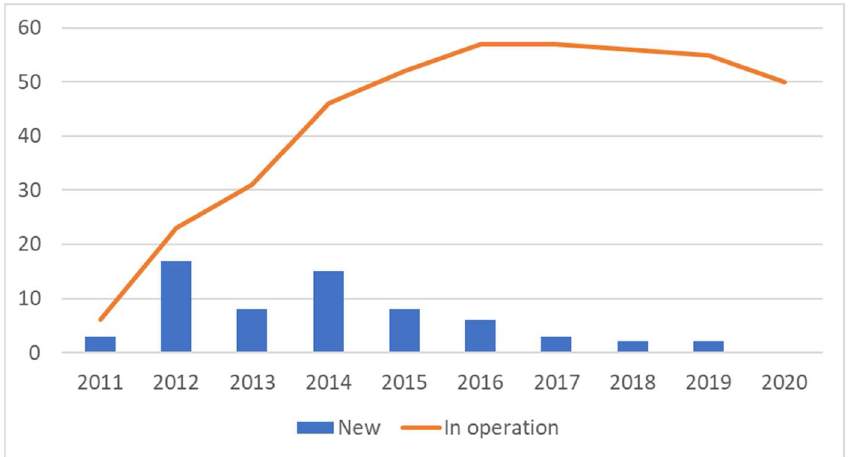
Figure 2. The number of Ki-no-Eki using community currencies ( Source : Izumi and Nakazato [7] (p.